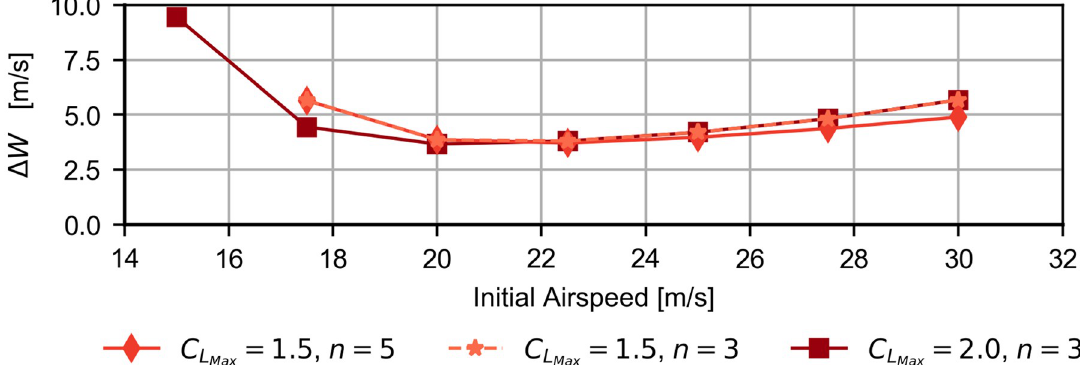
Fig 13. Effect of the vehicle constraints. Evolution of the required wind strength as a function of the initial airspeed for different vehicle constraints (lift coefficient C and load factor n L